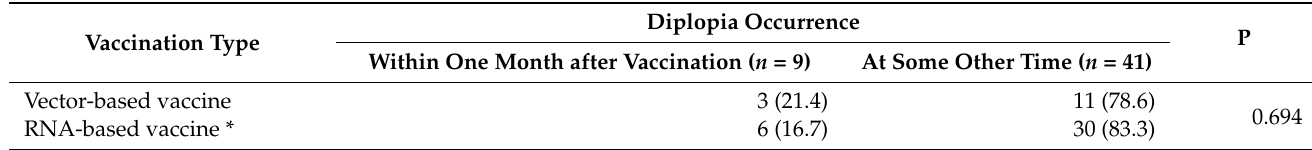
Table 2. Post-vaccine diplopia risk in vector- and RNA-based vaccinated patients.